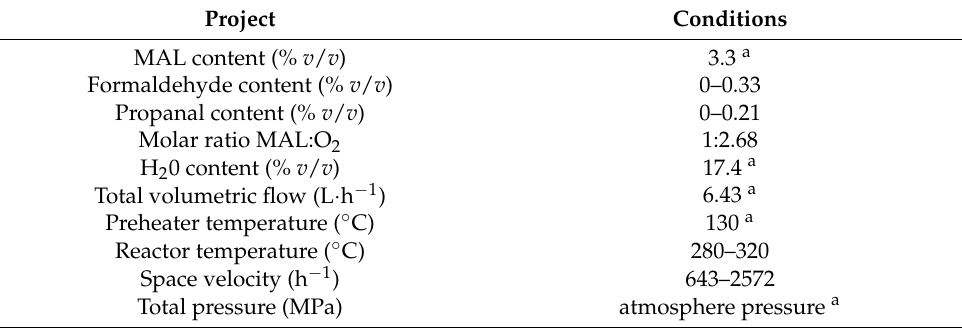
Table 2. Experimental conditions for the selective oxidation MAL to